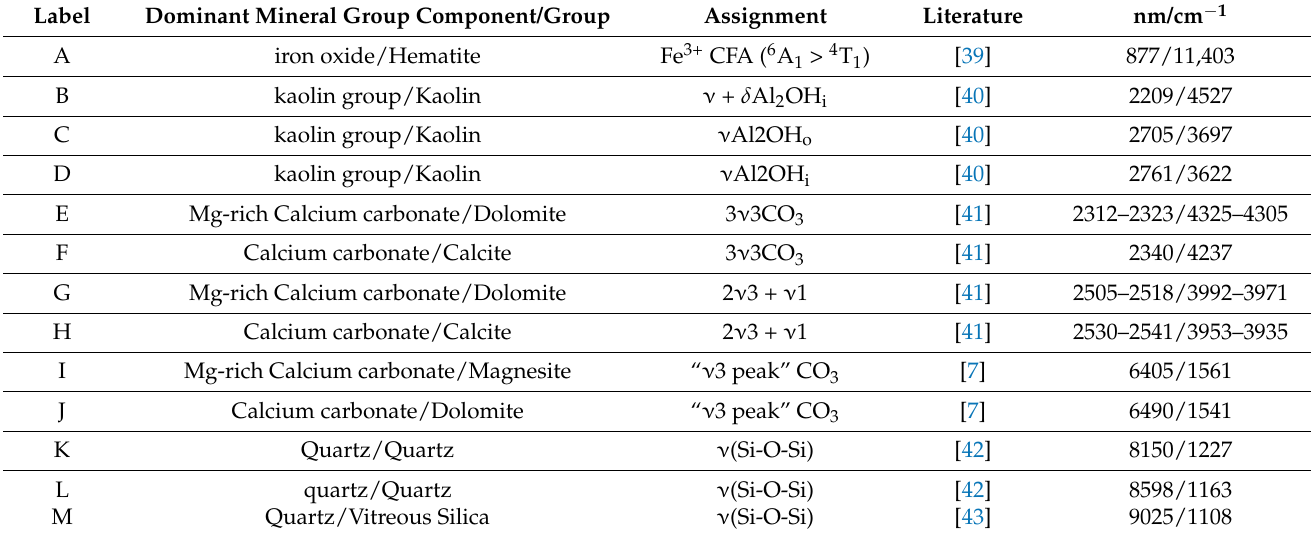
Figure 1. Indicative spectra selected from dataset four corresponding to the maximum value of a given geochemical parameters. The spectra are indicators only of the potential differences in reflectance that might be associated with a given parameter. It is expected, and confirmed, that certain whole-rock parameters will be consistent with given mineral assemblages. Complementary to this figure is Table 2 which provides a summary of some of the major absorption/emission features of minerals present in the study area and noted within the spectra. Table 2. A summary of some of the major absorption/emission features of minerals present in the study area. It is noted that respective absorption bands can be present in minerals that are not listed in table. The lower and upper wavelength positions are only given for absorption bands where related compositional changes occur otherwise, an estimated central location is